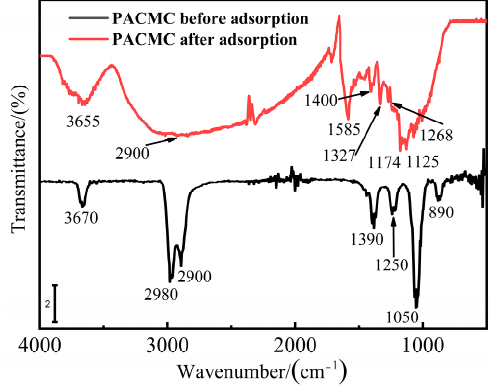
Figure 10. FTIR images of PACMC after adsorption.